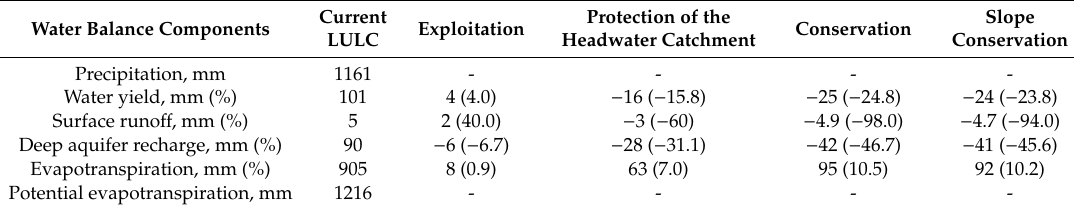
Table 4. Absolute and relative changes in selected water balance components due to future